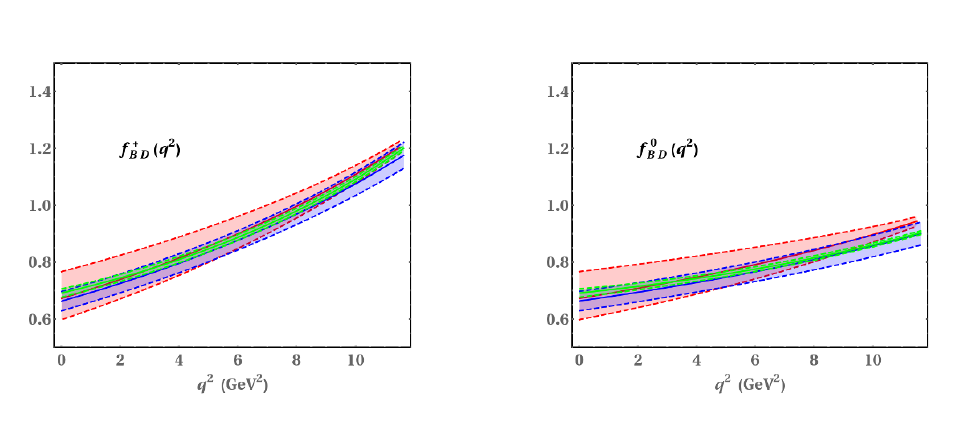
Figure 7 . The transfer momentum dependence of the form factor f + ( q 2 ) (left panel) and of BD the form factor f 0 ( q 2 ) (right panel) predicted from the LCSR calculations, including the two- BD particle contributions at (partial) NLL accuracy and the tree-level three-particle contributions, with an extrapolation toward large q 2 applying the z -series parametrization. The pink, blue and green curves correspond to theory predictions from this work, from the lattice QCD calculations by the HPQCD Collaboration [5], and from a combined (cid:12)t of the BarBar and Belle data as well as the HPQCD and FNAL/MILC calculations [68]. Theory uncertainties for all the calculations are indicated by the shaded